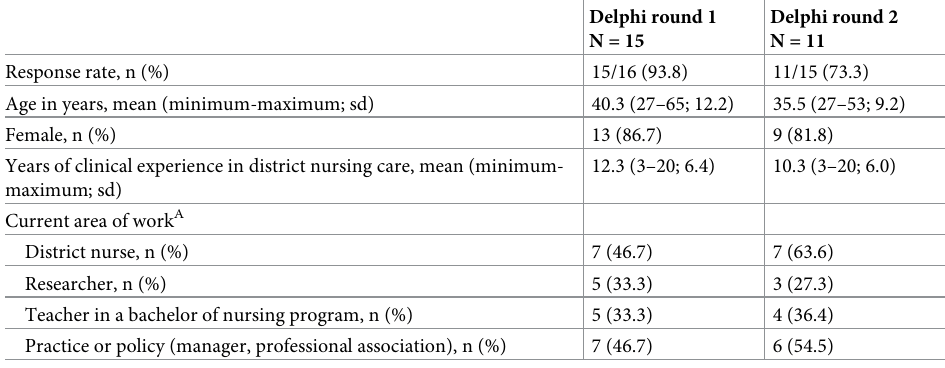
Table 1. Characteristics of the expert